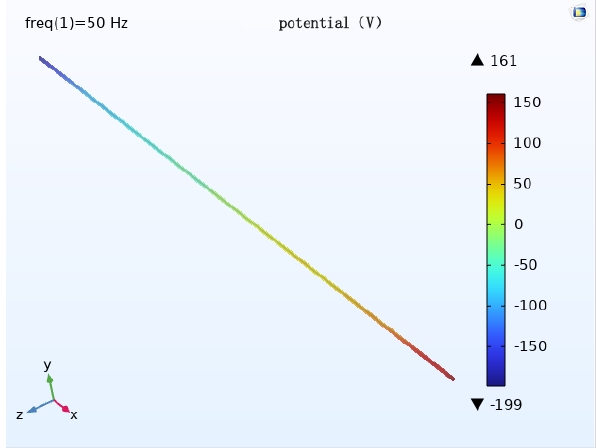
Figure 22. Distribution of cathodic protection potential when the conductors are triangulated.